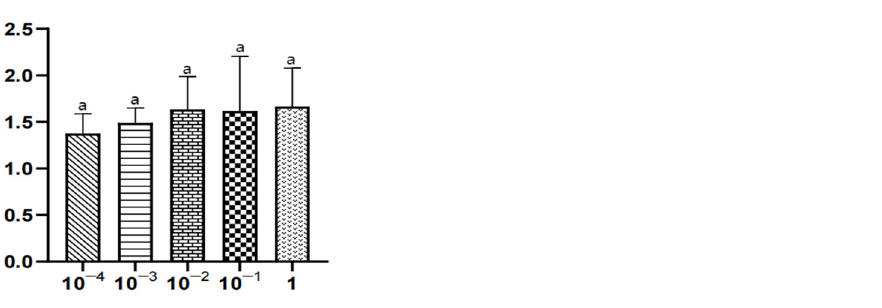
Figure 23. EAG responses of female W. magnifica to different concentrations of propyl butyrate.